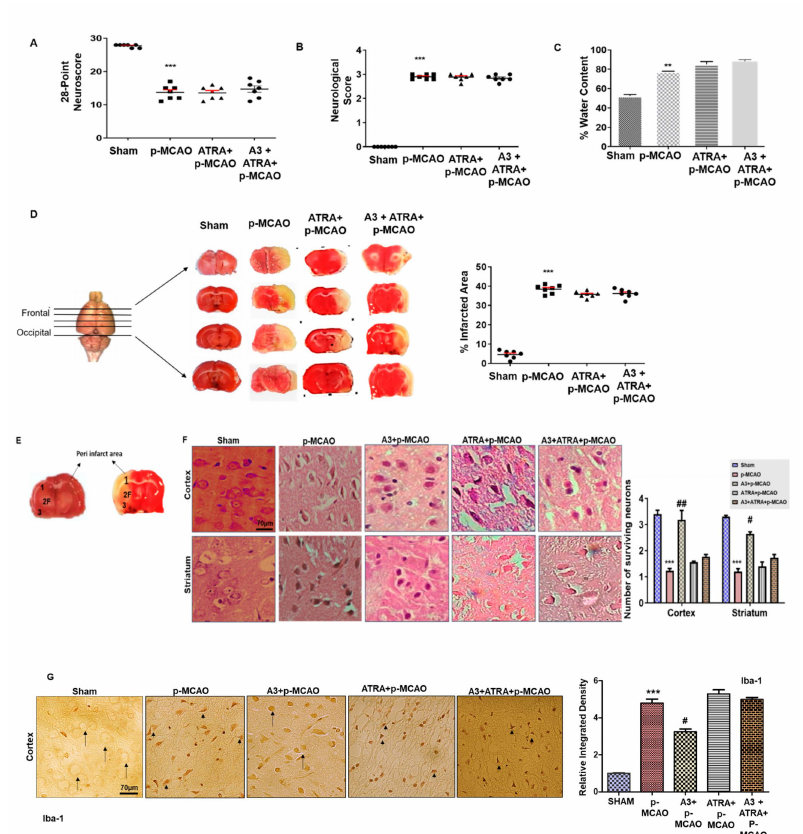
Figure 4. E ff ects of ATRA on A3 mediated neuroprotection. ( A ) 28 points composite scoring. ( B ) Bederson scale. ATRA + p-MCAO rats exhibited severe neurological impairment as with p-MCAO ( n = 7 / group). ( C ) The brain water content of the cerebral hemisphere in the ischemic side in each group ( n = 5 / group). ** p < 0.01 vs. sham group. ATRA + p-MCAO showed no significant changes in % water content / edema formation as compared to p-MCAO. ( D ) % Infarct area was quantified by TTC staining started from the frontal cortex to the occipital cortex, which di ff erentiates between ischemic and non-ischemic areas ( n = 7 / group). ( E ) Coronal sections indicating frontal cortex (1), parietal cortex and insular cortex (2), and the piriform cortex (3). The analyzed region of interests indicated by 1 and F. ( F ) Representative images of hematoxylin and eosin staining in various groups. Scale bar = 70 µ m. magnification 40 × . ( G ) Representative images of Iba-1 immunostaining in the cortex. Scale bar = 70 µ m, magnification 40 × . The thin arrows indicated normal neuronal cells while the arrowhead indicates microglial phenotype. *** p < 0.001 vs. sham, # p < 0.05 and ## p < 0.01 vs. p-MCAO